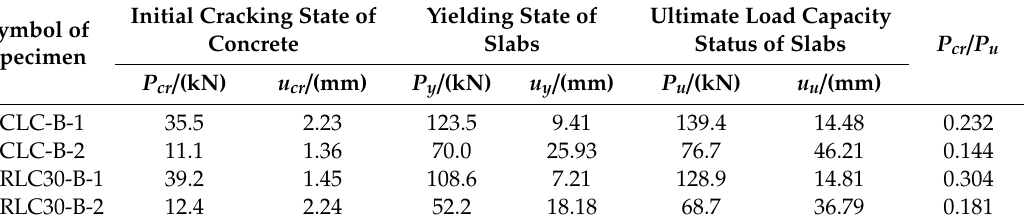
Table 7. The results from experimental tests.